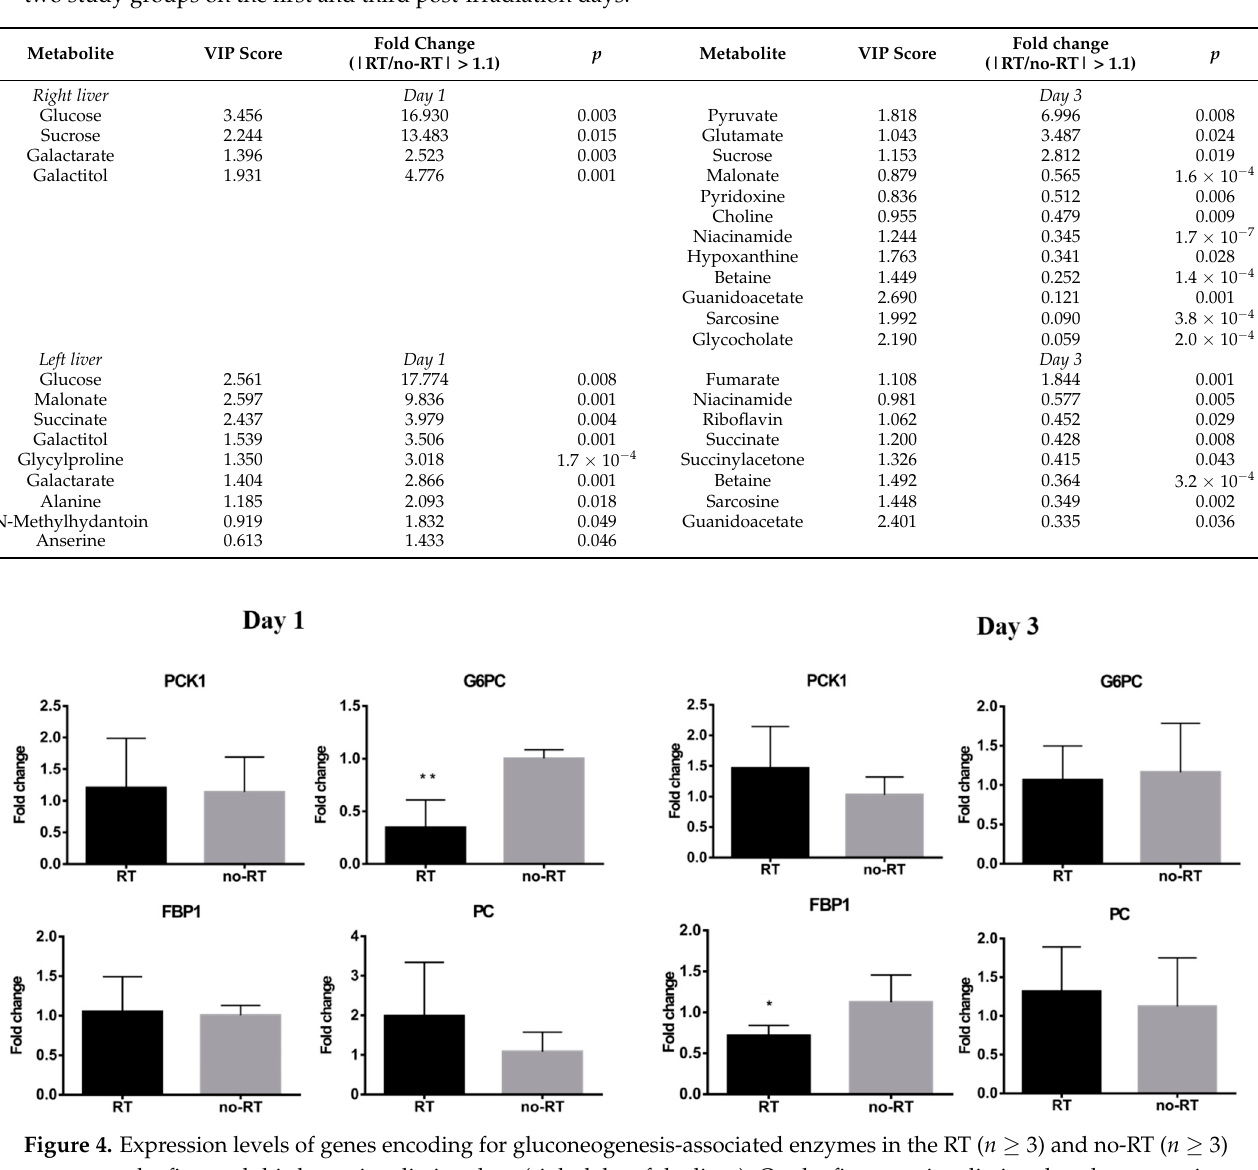
Table 1. Dynamic changes in the expression of different metabolites in the right and left lobes of the liver observed in the two study groups on the first and third post-irradiation days.